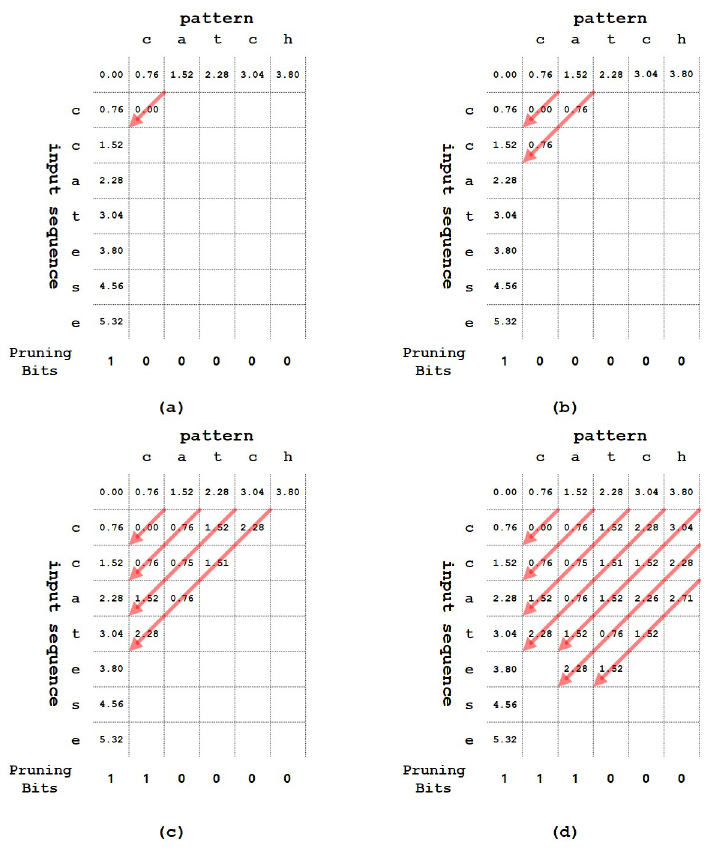
Fig 5. An example of proposed method using pruning